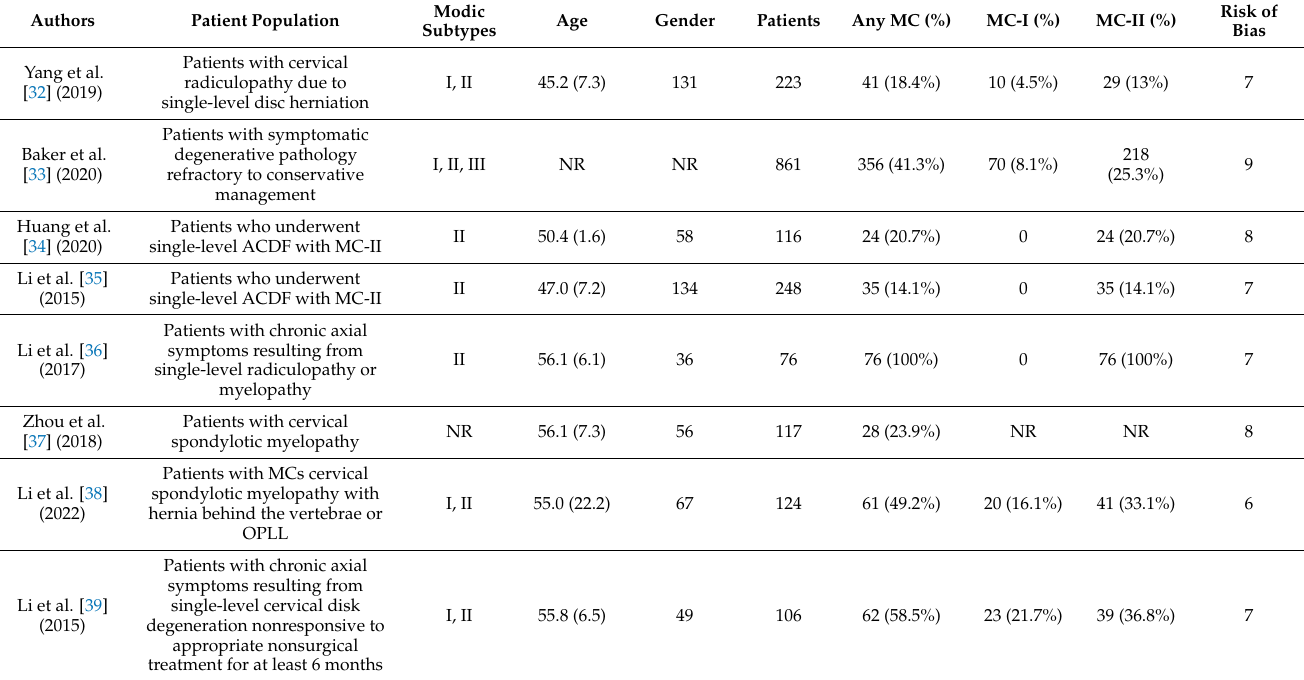
Table 1. The patient characteristics of studies evaluating the cervical spine.